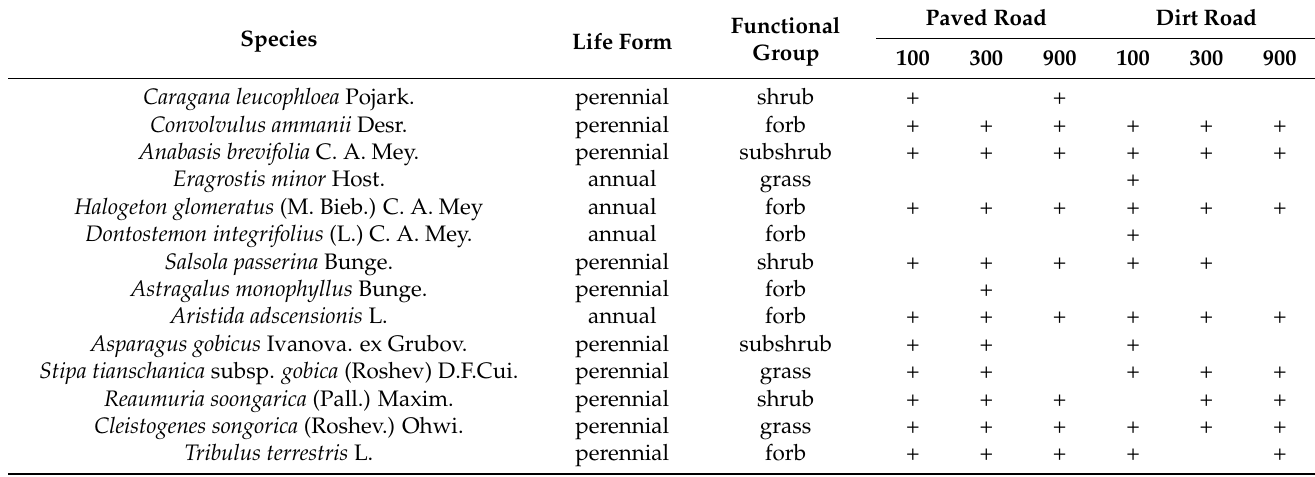
Table 2. Plant species composition along the paved and soil roads, and their life form and functional